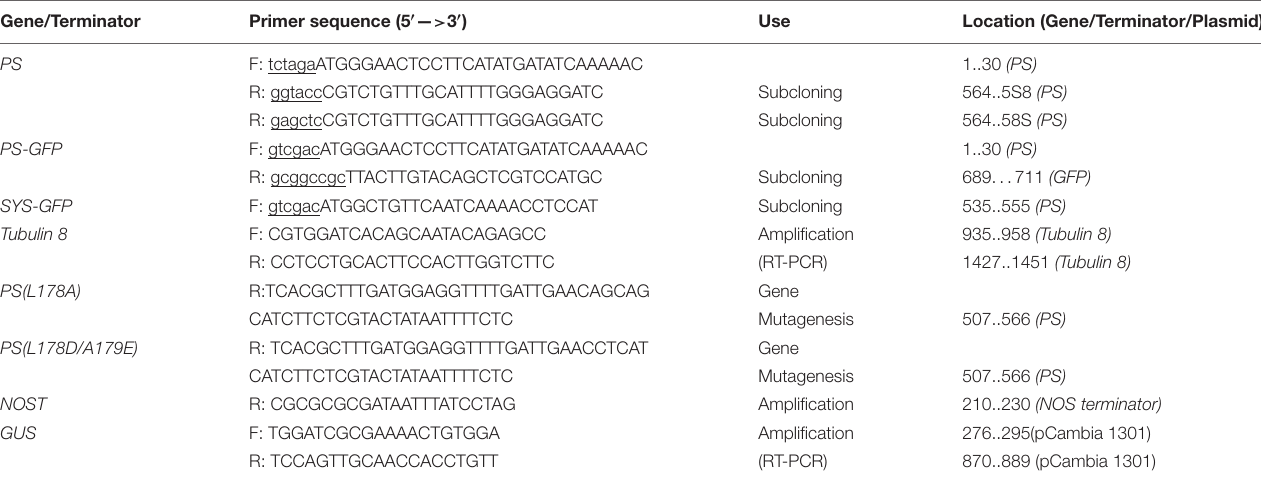
TABLE 1 | List of primers used in this